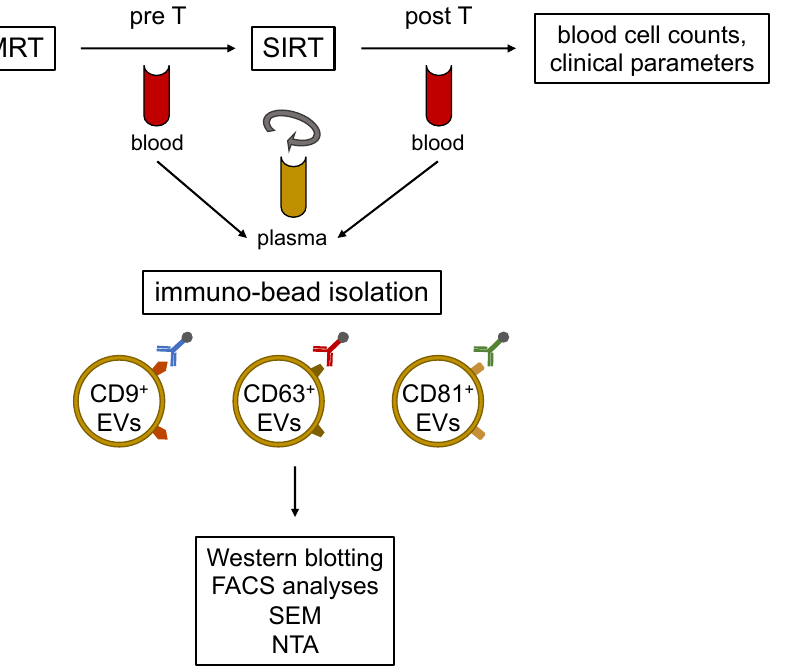
Figure 1. Schematic illustration of the experimental workflow. Cholangiocellular carcinoma (CCA) patients received a liver MRI according to the clinical standards. Blood samples were taken before (pre T) and after (post T) selective internal radiation therapy (SIRT). Extracellular vesicles (EVs) were isolated from plasma using CD9+, CD63+, and CD81+ exosome markers in the immune-bead isolation. The isolated EVs populations are distinguishable by flow cytometry (FACS). The presence of EVs was assessed by western blotting, and in addition to the characterization of EVs, their morphology was analyzed by scanning electron microscopy (SEM) and nanoparticle tracking analysis (NTA).